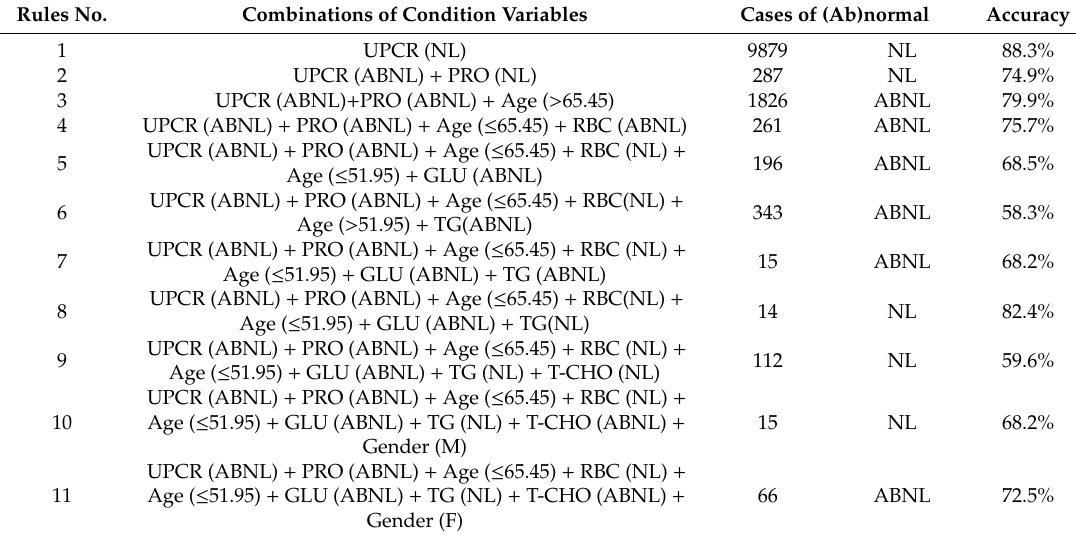
Figure 2. Classification tree depicting CKD predictors of C4.5. Table 5. Summarized rules of condition